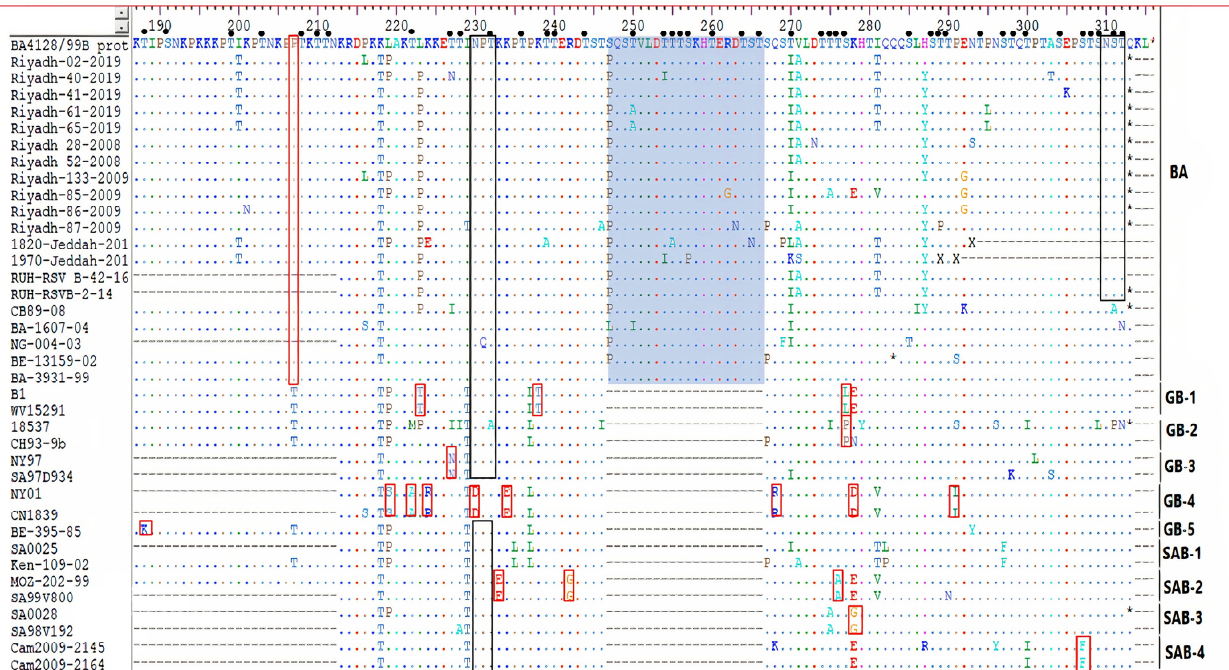
Figure 3. Deduced AA sequence alignment of 2nd HVR of G protein gene of the HOPV-B. The alignment was performed by the Clustal W method running within the MegAlign program (DNAstar). Alignment is shown relative to the BA prototype strain from Argentina. Dots are indicated for identical AA residues, while sequence variation is identified in single-letter code. The duplicated regions are shown in the green rectangles. Red rectangles color = the AA residues specific to HOPV-genotype. Predicted N-glycosylation sites are enclosed in black rectangles. Small filled circles = predicted O-glycosylation sites.